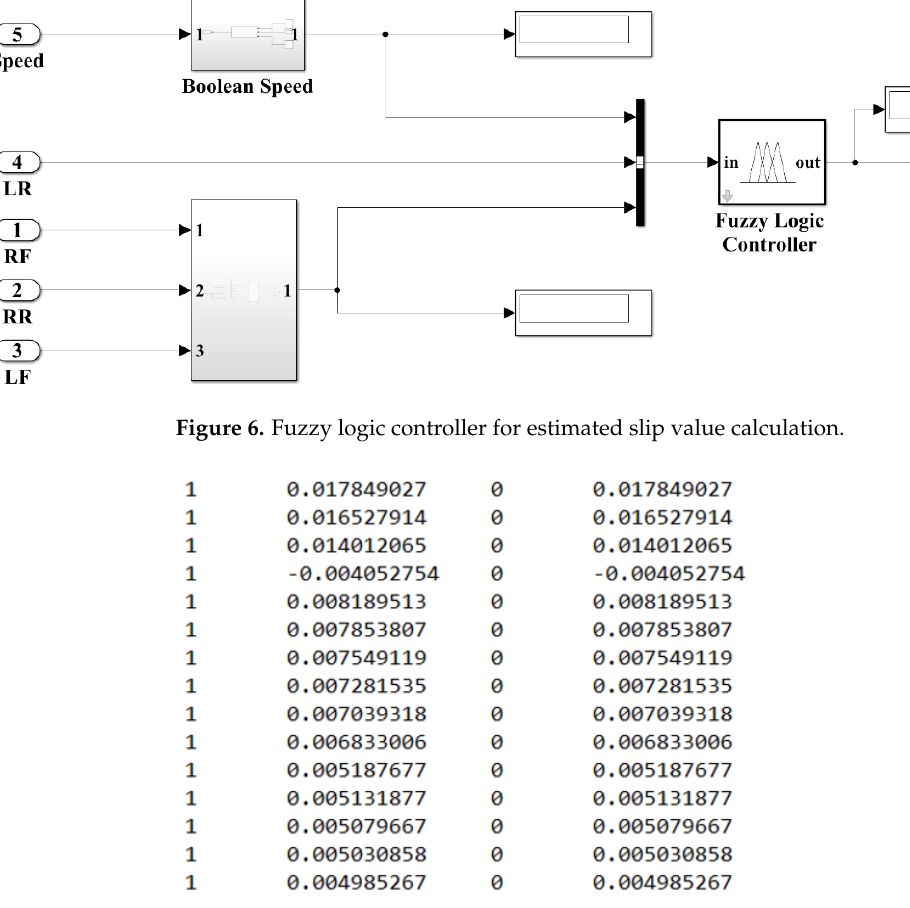
Figure 7. Data set values for the training of the fuzzy neural network.